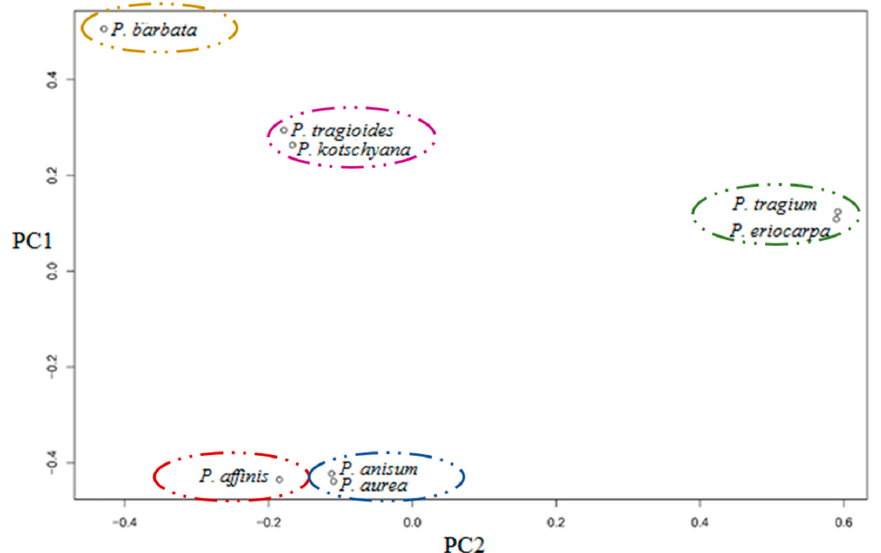
Figure 2. Diagram resulting from the analysis of principal components of the studied species of Pimpinella .